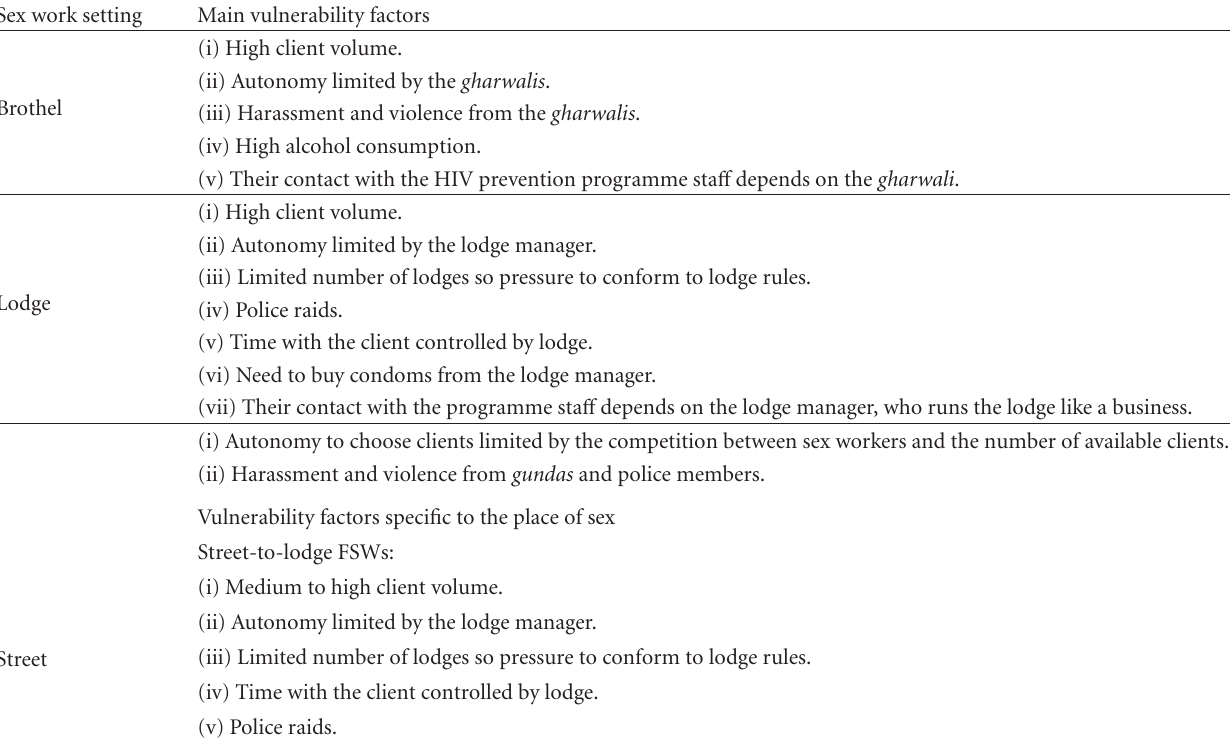
Table 1: Summary of main vulnerability factors by type of sex work